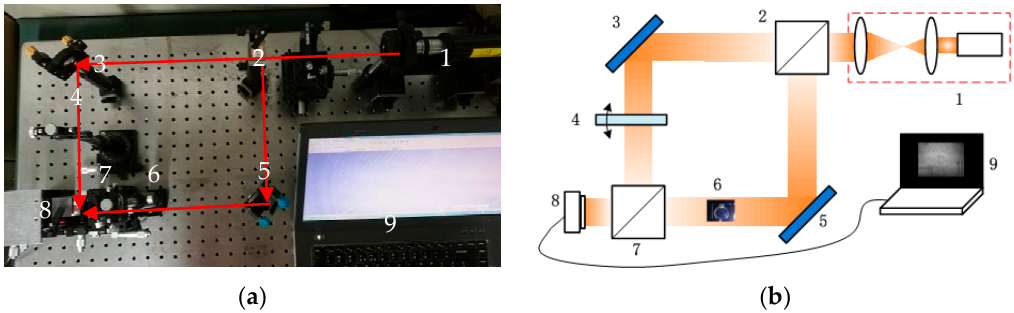
Figure 4. System setup of two-step quadrature phase-shifting holography (QPSH). ( a ) Experimental optical system; ( b ) Schematic illustration of Figure 3a: 1 = He-Ne laser and collimator, 2, 7 = Beam splitter, 3, 5 = Reflective mirror, 4 = Optical flat glass plate, 6 = Test sample, 8 = charge-coupled device (CCD), 9 = Computer.